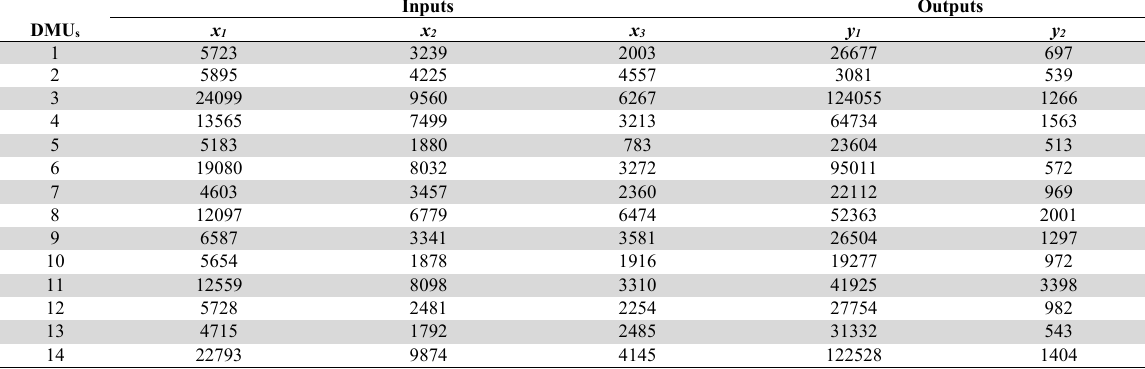
Data set of fourteen international passenger